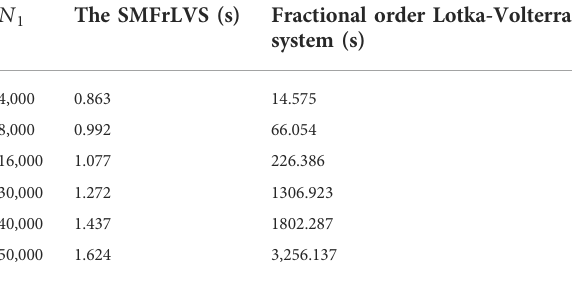
TABLE 1 Time comparison between the SMFrLVS and the fractional order Lotka-Volterra system. N